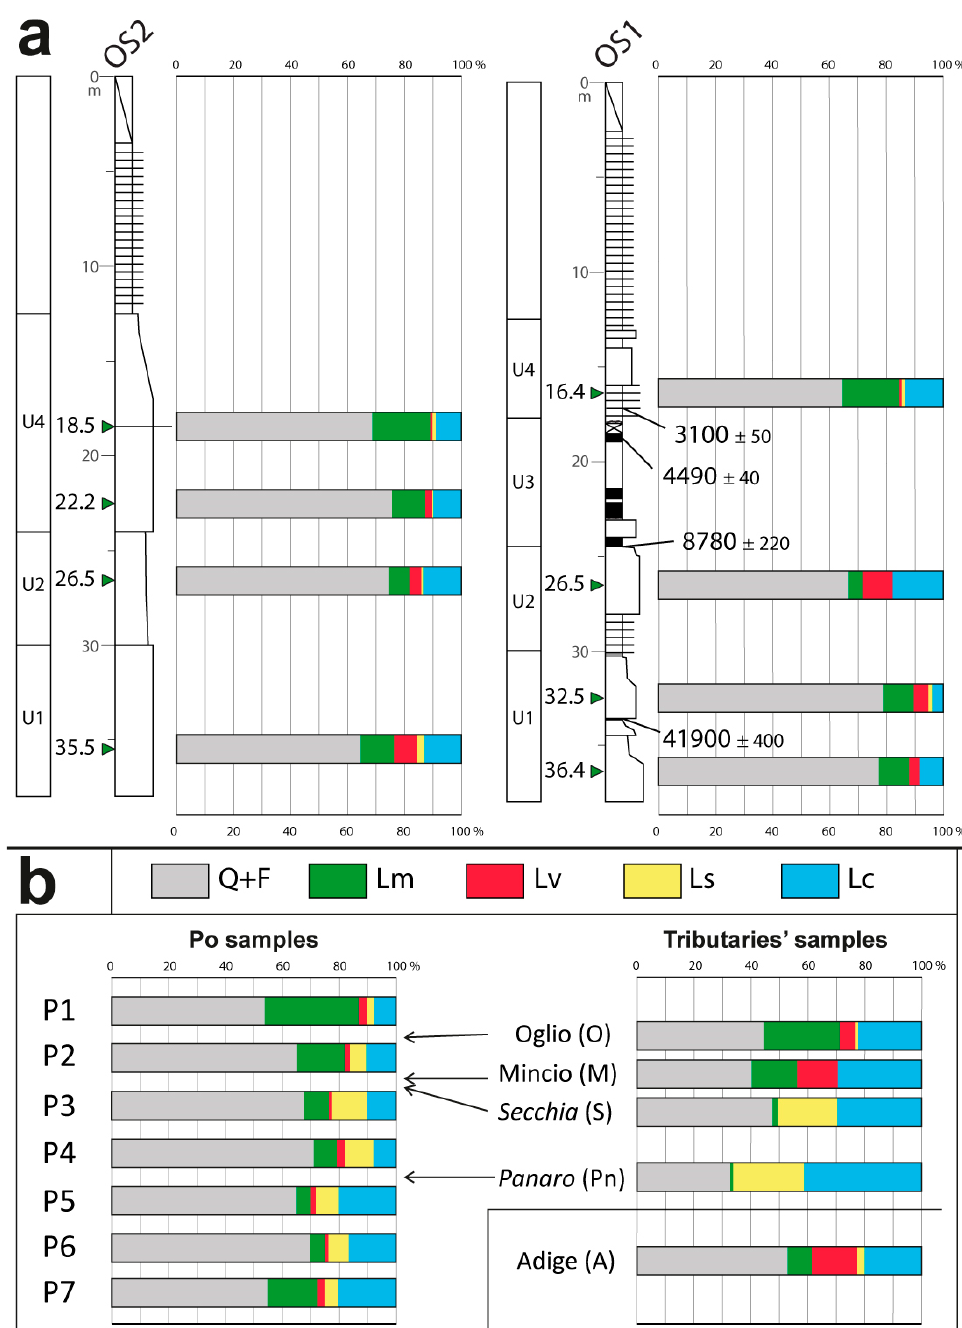
Figure 6. Composition of sand samples reported as barchart ( a ): composition of sands from OS2 and OS1 reported in the logs at the sampling level. ( b ): composition of sands from the modern Po, Oglio, Mincio, Secchia, Panaro and Adige rivers. The arrows indicate river confluences. The Adige River is shown in a separate box as it is not a Po tributary. Apennine rivers are in italics.